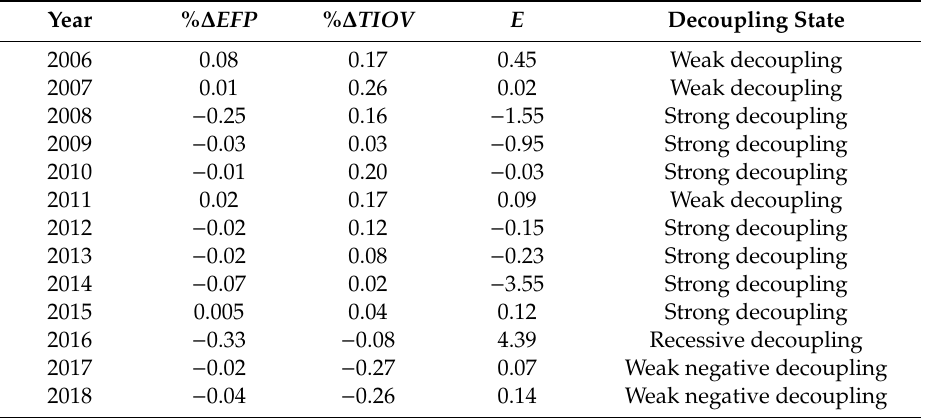
Table 3. Decoupling state between TIOV and EFP of Shaoxing.